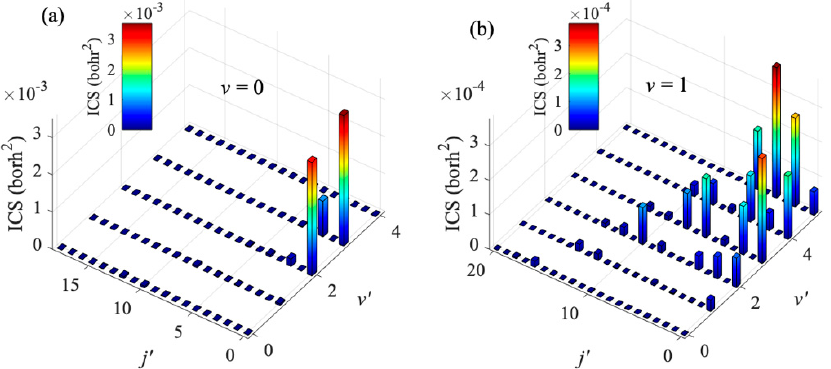
Figure 6. Ro-vibrational state distribution of H 2 from electronic quenching of Na(3p) + H 2 ( v ) → Na(3s) + H 2 ( v ′ , j ′ ) collision with ( a ) v = 0, and ( b ) v = 1 at collision energy of 0.1 K.